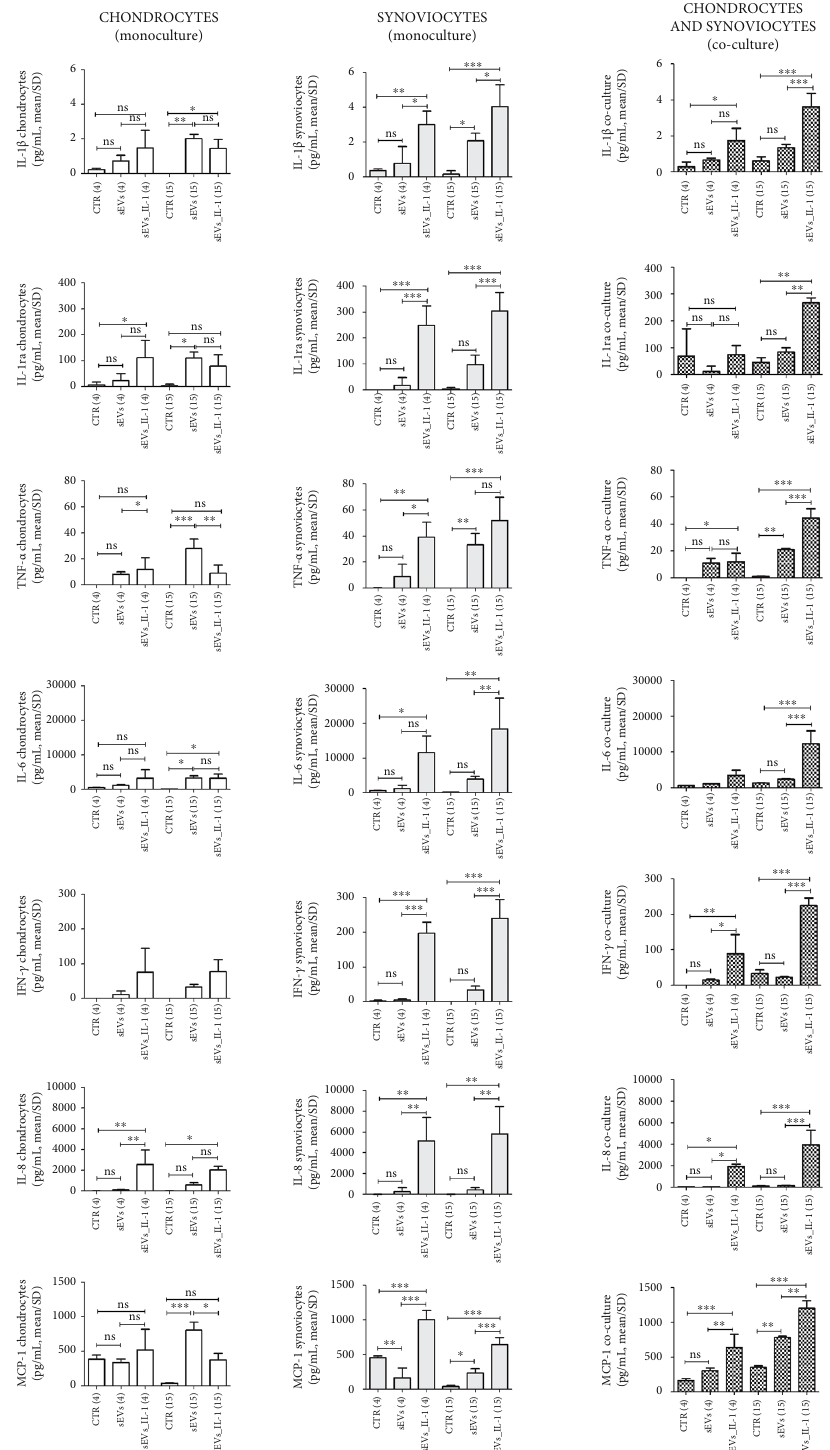
Figure 6: sEVs_IL-1 e ff ects on the protein release of major in fl ammatory molecules (IL-1 β , IL-1ra, TNF- α , IL-6, IFN- γ , IL-8, and MCP-1) as assessed by Bioplex. Flanked results obtained from chondrocytes (white pattern), synoviocytes (grey pattern), and co-culture of these cells (pixelated pattern). For each cell type, results are shown obtained in CTR, sEVs, or sEVs_IL-1 conditions. Each graph reports data collected from 3 independent sEVs samples and expressed as means ± SD . Data were compared by ANOVA, followed by Tukey ’ s post hoc test, with ∗ p < 0 : 05 , ∗∗ p < 0 : 01 , and ∗∗∗ p < 0 : 001